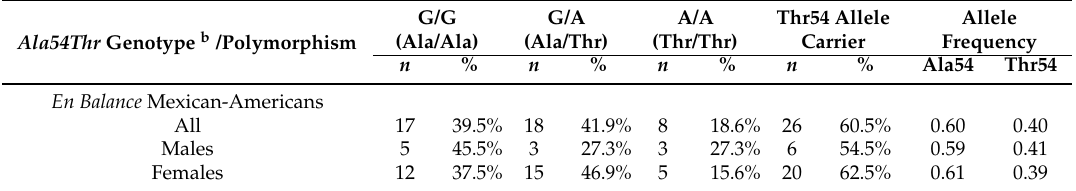
Table 1. En Balance Mexican-American FABP2 Ala54Thr polymorphism a genotype and allele frequencies.